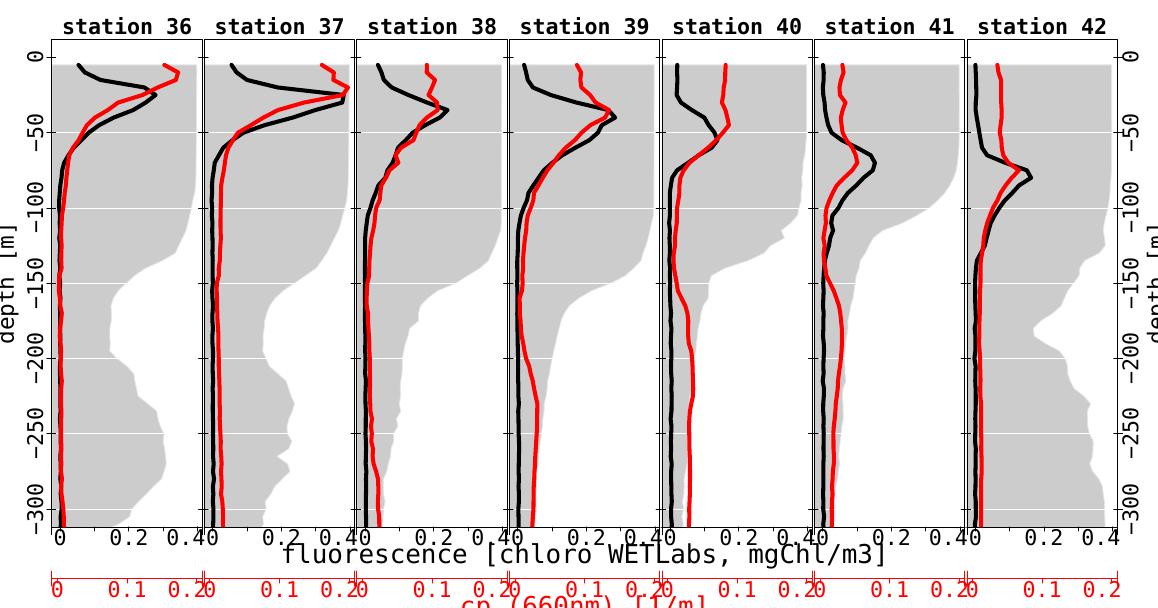
Figure 5. Vertical profiles of fluorescence and c p with oxygen concentration background (grey colour, for units see Fig.